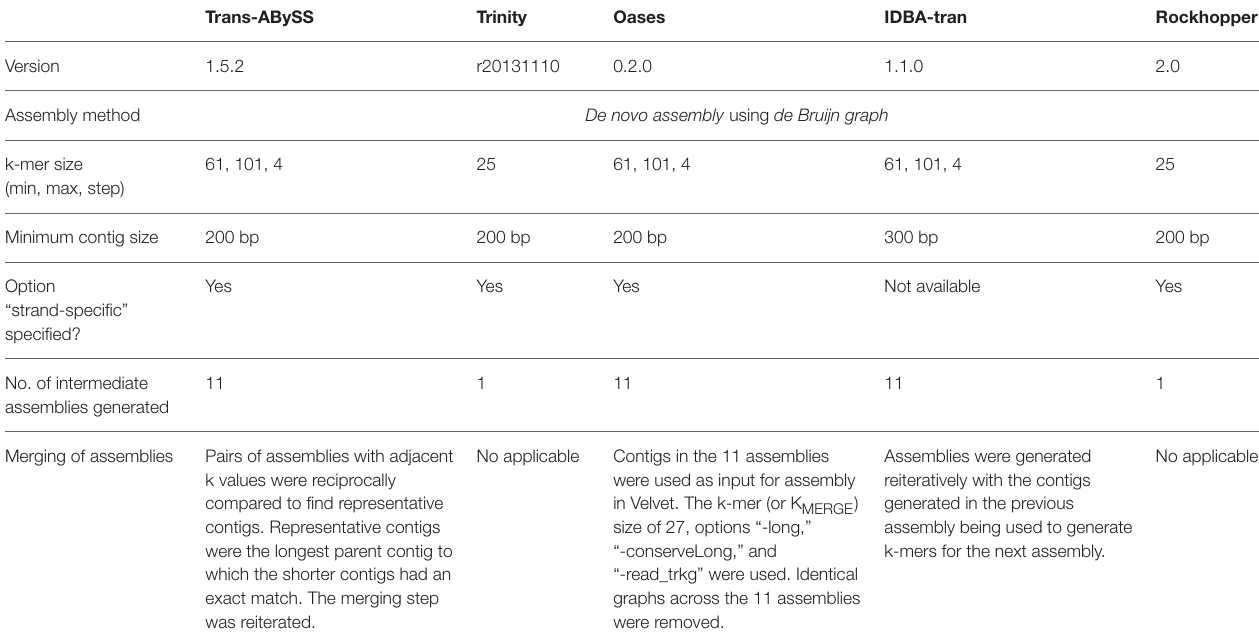
TABLE 1 | Summary of strategies used for generating metatranscriptomic